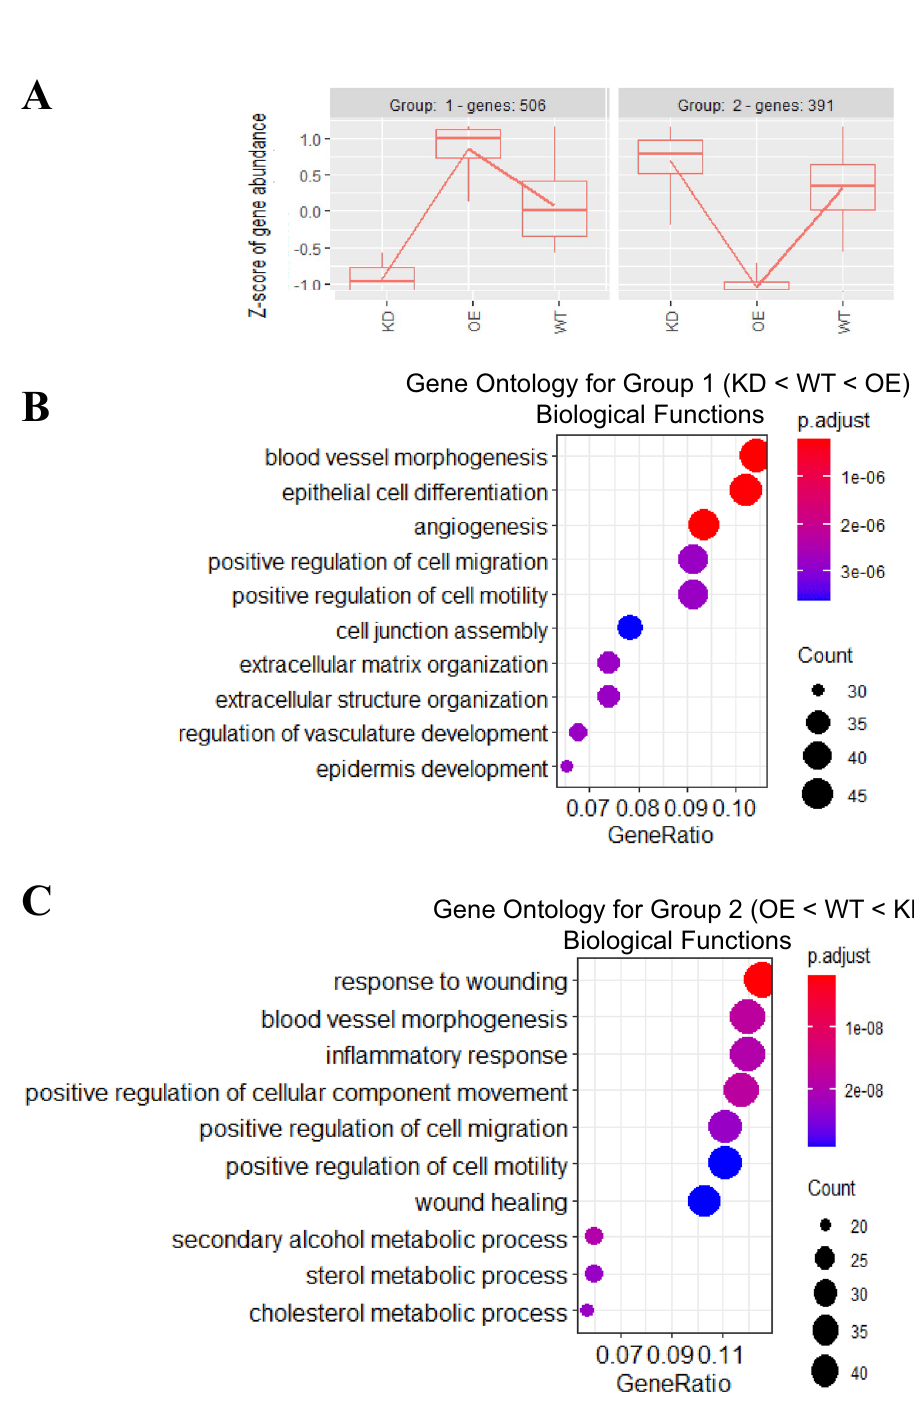
Figure 3. Transcriptome patterns and properties of genes impacted by EMP2 modification. Changes in gene expression across wild type (WT), EMP2 overexpressing (OE), and EMP2 knock down (KD) ARPE-19 cells were queried by the likelihood ratio test. ( A ) Hierarchical clustering analysis of the top 1000 significant genes (FDR < 0.01) by the degPatterns tool within the DEGreport R package (version 1.26.0) reveals four distinct expression profile groups. ( B , C ) Enriched biological property gene ontology (GO) terms for group 1 and group 2 cluster genes, respectively. The top 10 GO terms ordered by gene ratio (number of GO term-related genes divided by total number of significant genes) identify angiogenesis and vasculature-related terms as significantly enriched for group 1 genes. Dot color represents the Benjamini–Hochberg adjusted p value for each enriched GO term. All samples were performed in